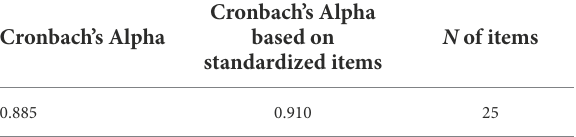
TABLE 2 Reliability statistics.